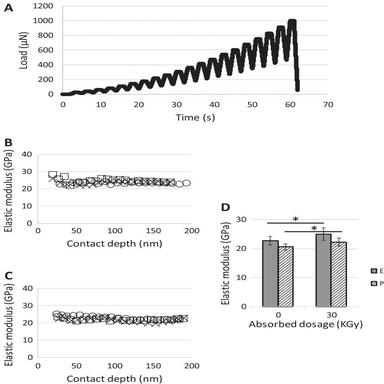
An indentation load function was used in this study to enable depth profiling of the elastic moduli of the EDJD and PDJD with or without x-ray irradiation (A). Elastic moduli versus contact depth of the EDJD (B) and PDJD (C). The values of three indentation data were merged. The average elastic modulus within the effective measurement range from 40 nm to 200 nm (D). Results are expressed as mean ± standard deviation (n.9 on the same sample surface). A p-value of less than 0.05 was considered significant (\)